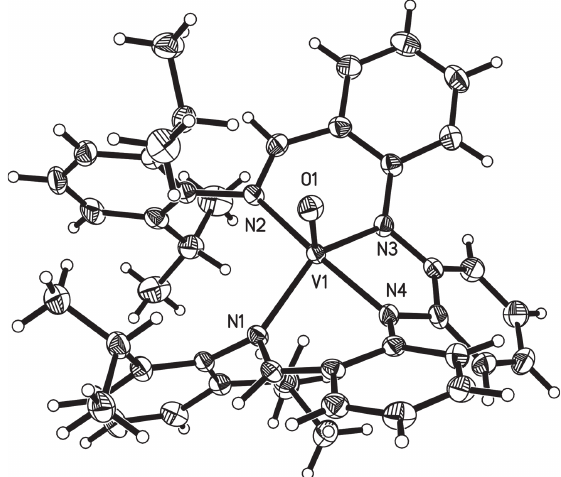
Table 1: Data collection and handling.